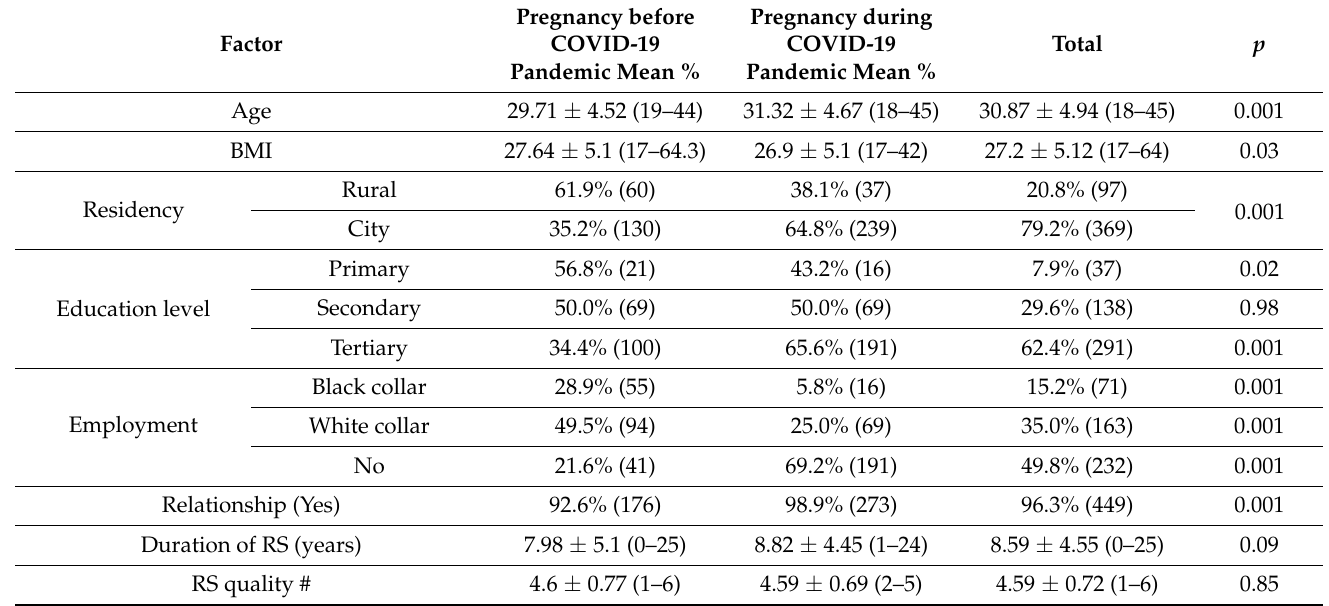
Table 1. Socio-demographic and psychological characteristics of study